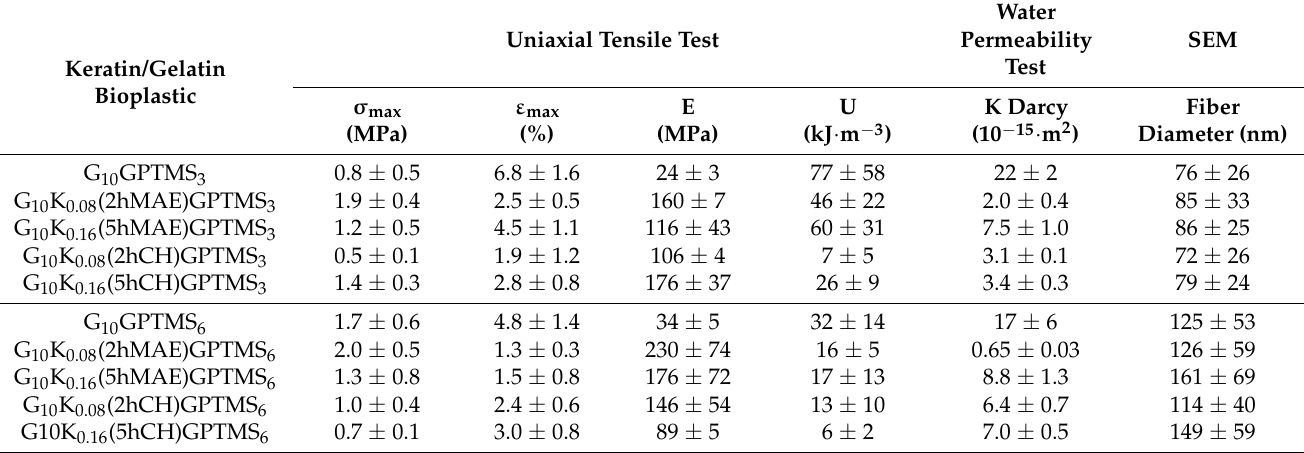
Table 3. Results from uniaxial tensile tests ( σ max = failure stress; ε max = failure strain; E = elastic modulus; U = toughness), water permeability (K Darcy) and SEM analysis (Fiber diameter). Results are expressed as average ± standard deviation ( N = 3